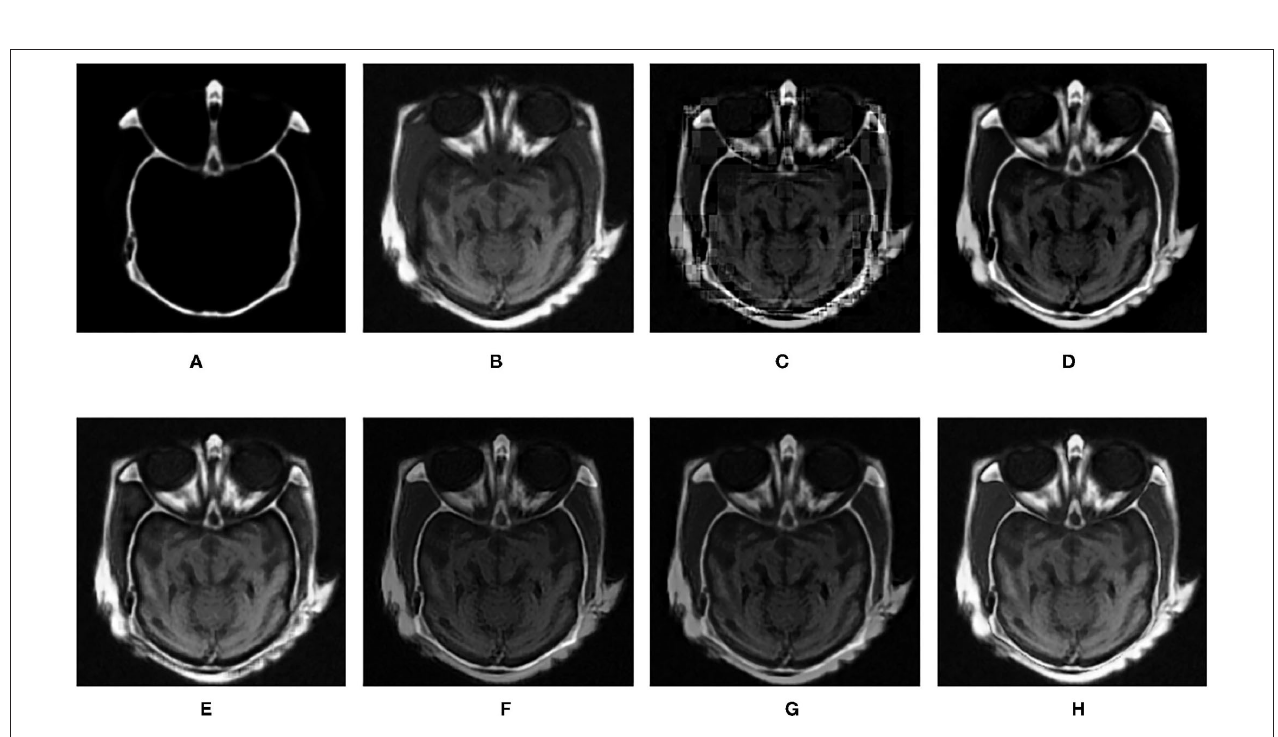
FIGURE 14 | Comparison experimental results of CT and MRI images. (A) original image (CT); (B) original image (MRI); (C) DWT; (D) LP; (E) SR; (F) DTCWT-SR; (G) VGG; (H) MPS.